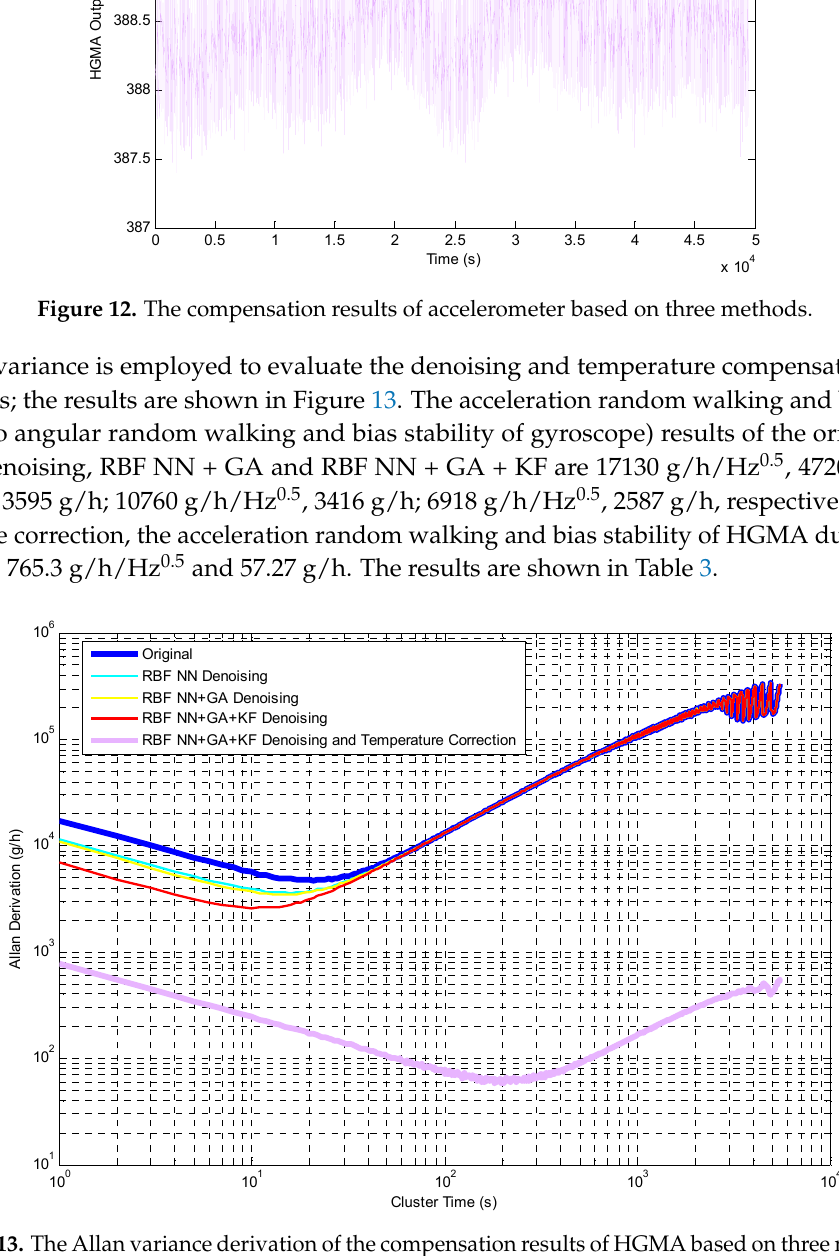
Figure 13. The Allan variance derivation of the compensation results of HGMA based on three methods. Table 3. Results of Allan variance analysis.